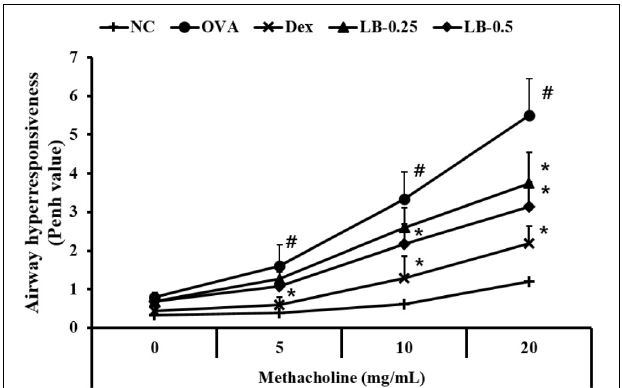
FIGURE 1 | Effects of lobeglitazone (LB) on airway hyperresponsiveness (AHR) of OVA-challenged animals. AHR was measured using plethysmography 24 h after the final OVA challenge, in mice given various doses of methacholine (5–20 mg/ml). NC, normal control mice; OVA, OVA-sensitized/challenged mice; Dex, dexamethasone (3 mg/kg) + OVA-sensitized/challenged mice; LB-0.25 and –0.5, LB (250 µ g/kg or 500 µ g/kg, respectively) +OVA-sensitized/challenged mice. Values are expressed as mean ± SD ( n = 6/group). # Significantly different from NC, P < 0.05. ∗ Significantly different from OVA, P <